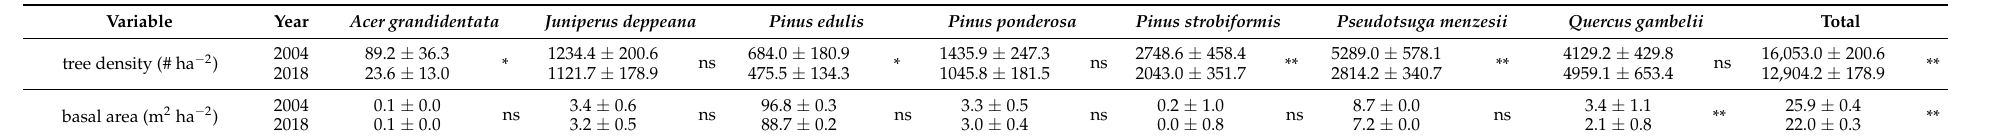
Table 1. Means (+1 S.E.) of seedling density, tree density, and basal area for all plots and by species prior to and one year after the Coyote Fire in Guadalupe Mountains National Park, Texas. Significant differences between the pre- and post-fire sampling interval according to paired t -tests are displayed with asterisks (NS = not significant, * = p < 0.05, and ** = p <